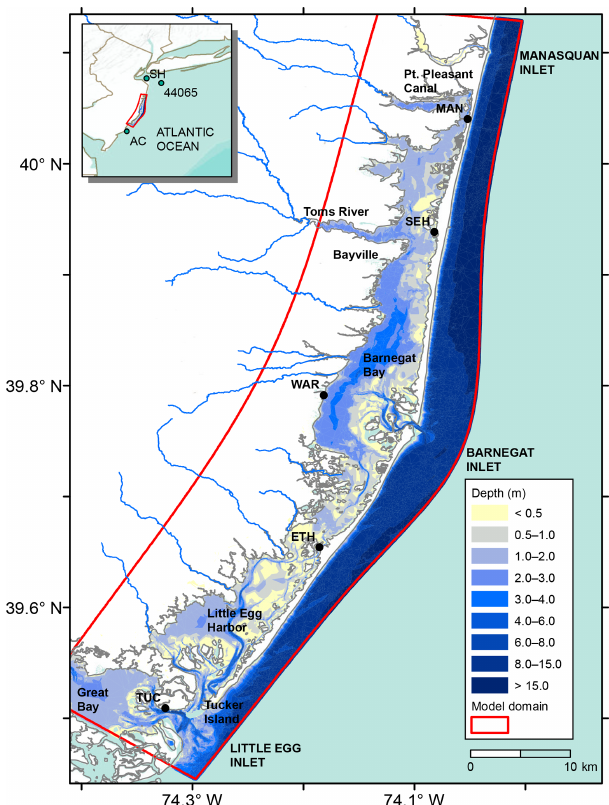
Figure 1. Map of Barnegat Bay and Little Egg Harbor estuary showing the water level stations, bays, and inlets. The water level stations are Tuckerton (TUC), East Thorofare (ETH), Waretown (WAR), Seaside Heights (SEH), and Mantoloking (MAN). Loca- tions of offshore water level proxy stations and wind buoys are in- dicated in inset. The COAWST model domain boundary is shown in red. Route 72 crosses the bay near ETH station and the breach that occurred during Hurricane Sandy was about 100m away from MAN station, so they are not indicated in the